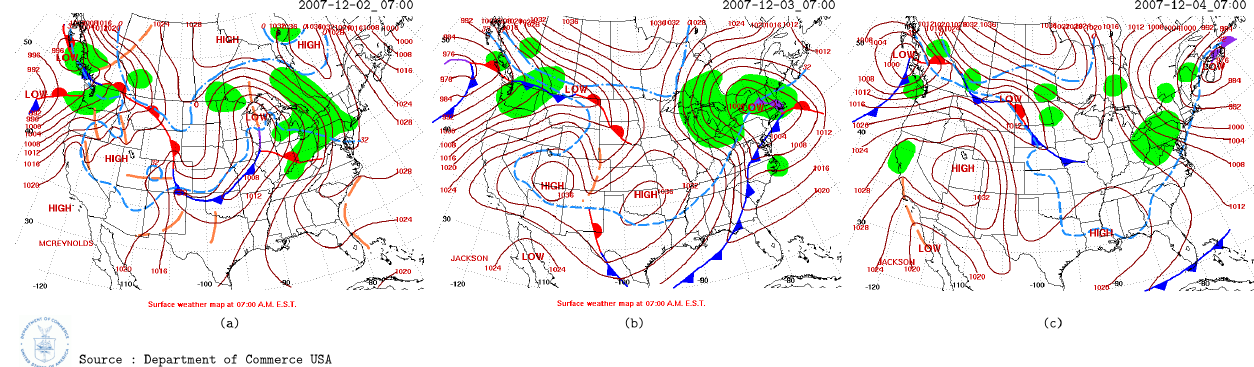
Figure A1. Front maps for the Pacific Great Coastal Gale of 2007 event.